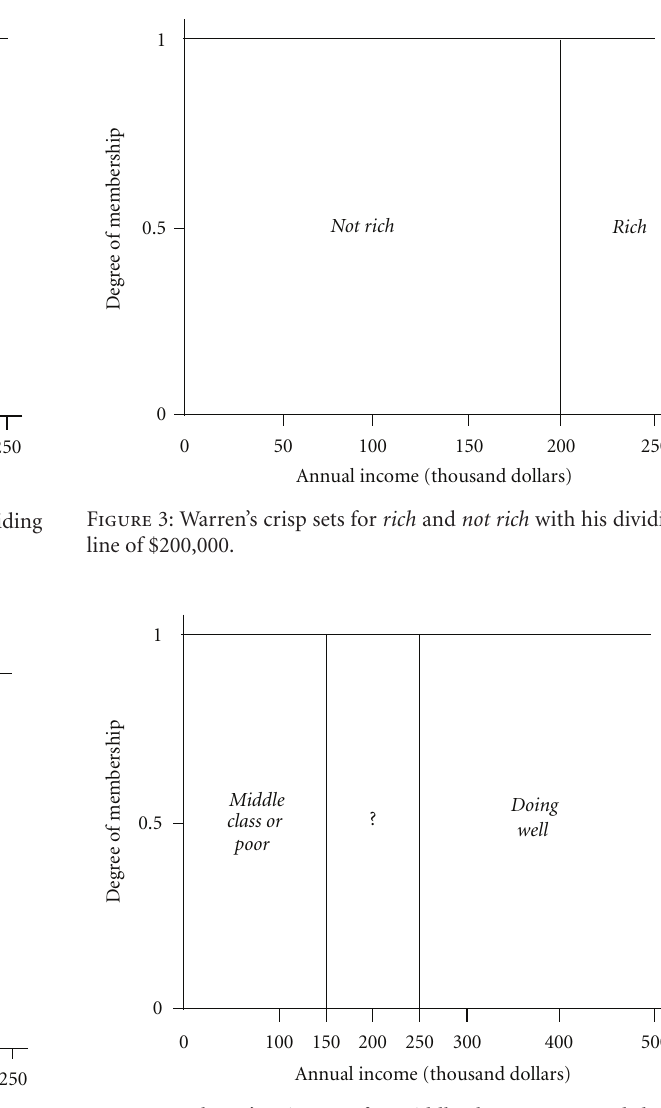
Figure 4: Obama’s crisp sets for middle class or poor and doing